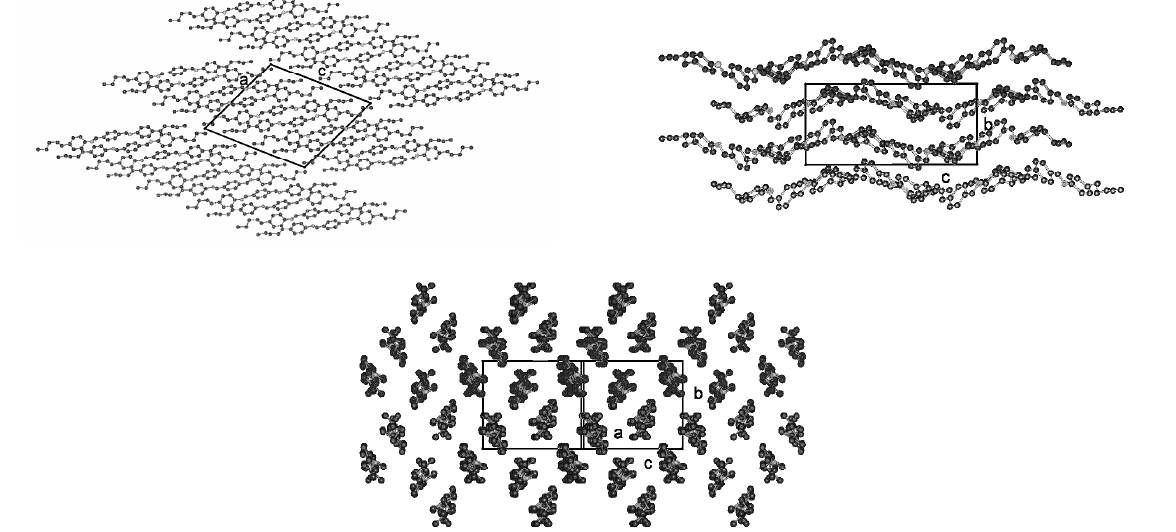
Figure 32. Representation of the distorted packing arrangement of TBAA-5(2) crystallizing in space group P2 /c in a,c-projection, b,c-projection and in a projection down 1 the molecular axes.